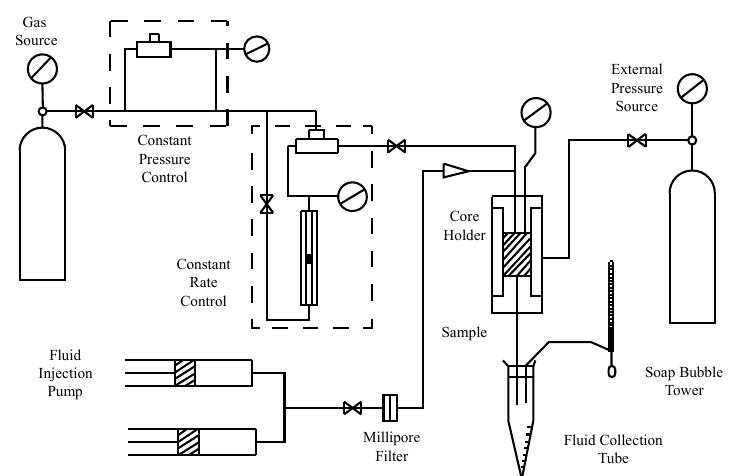
Figure 7. Schematic diagram of the relative permeability apparatus [56].